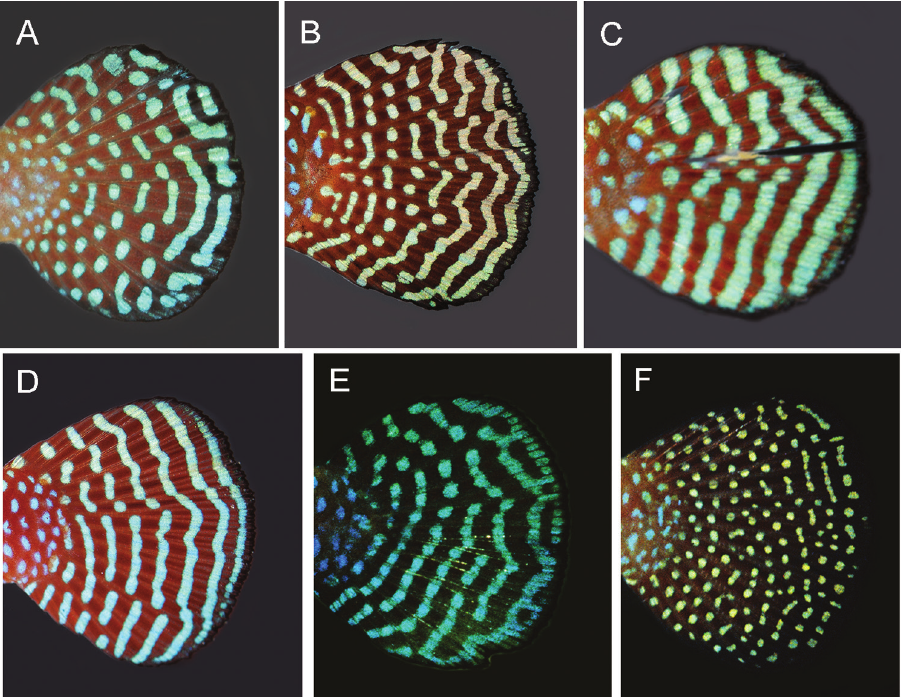
Figure 5. Caudal fin of live males of the Hypsolebias magnificus species complex. A H. harmonicus , holo- type, UFRJ 6696, 29.4 mm SL B H. gardneri sp. n., paratype, UFRJ 6797, 34.4 mm SL C H. hamadryades Costa sp. n., paratype, UFRJ 6895, 24.8 mm SL D H. magnificus , specimen from Gado Bravo, UFRJ 4959, 31.2 mm SL E H. magnificus , topotype not preserved, about 25 mm SL F H. picturatus . Paratype, UFRJ 5053, 38.6 mm SL. Photographs by WJEM